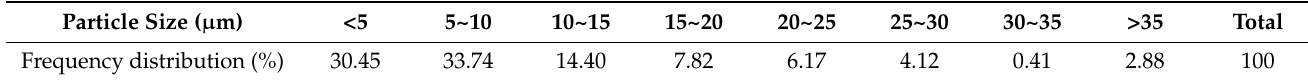
Table 1. Dust particle size distribution and frequency distribution.